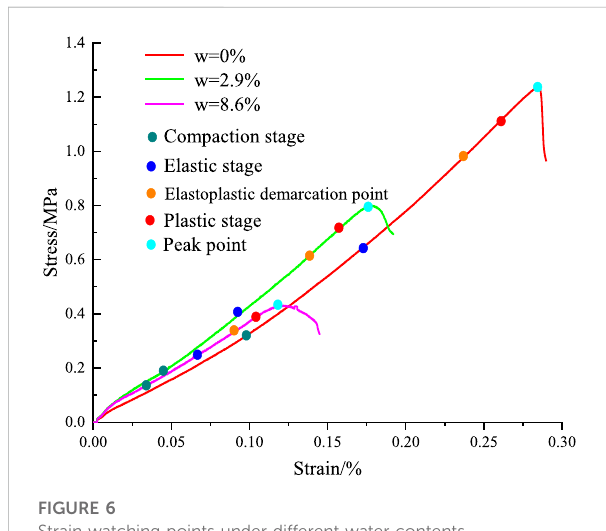
FIGURE 6 Strain watching points under different water